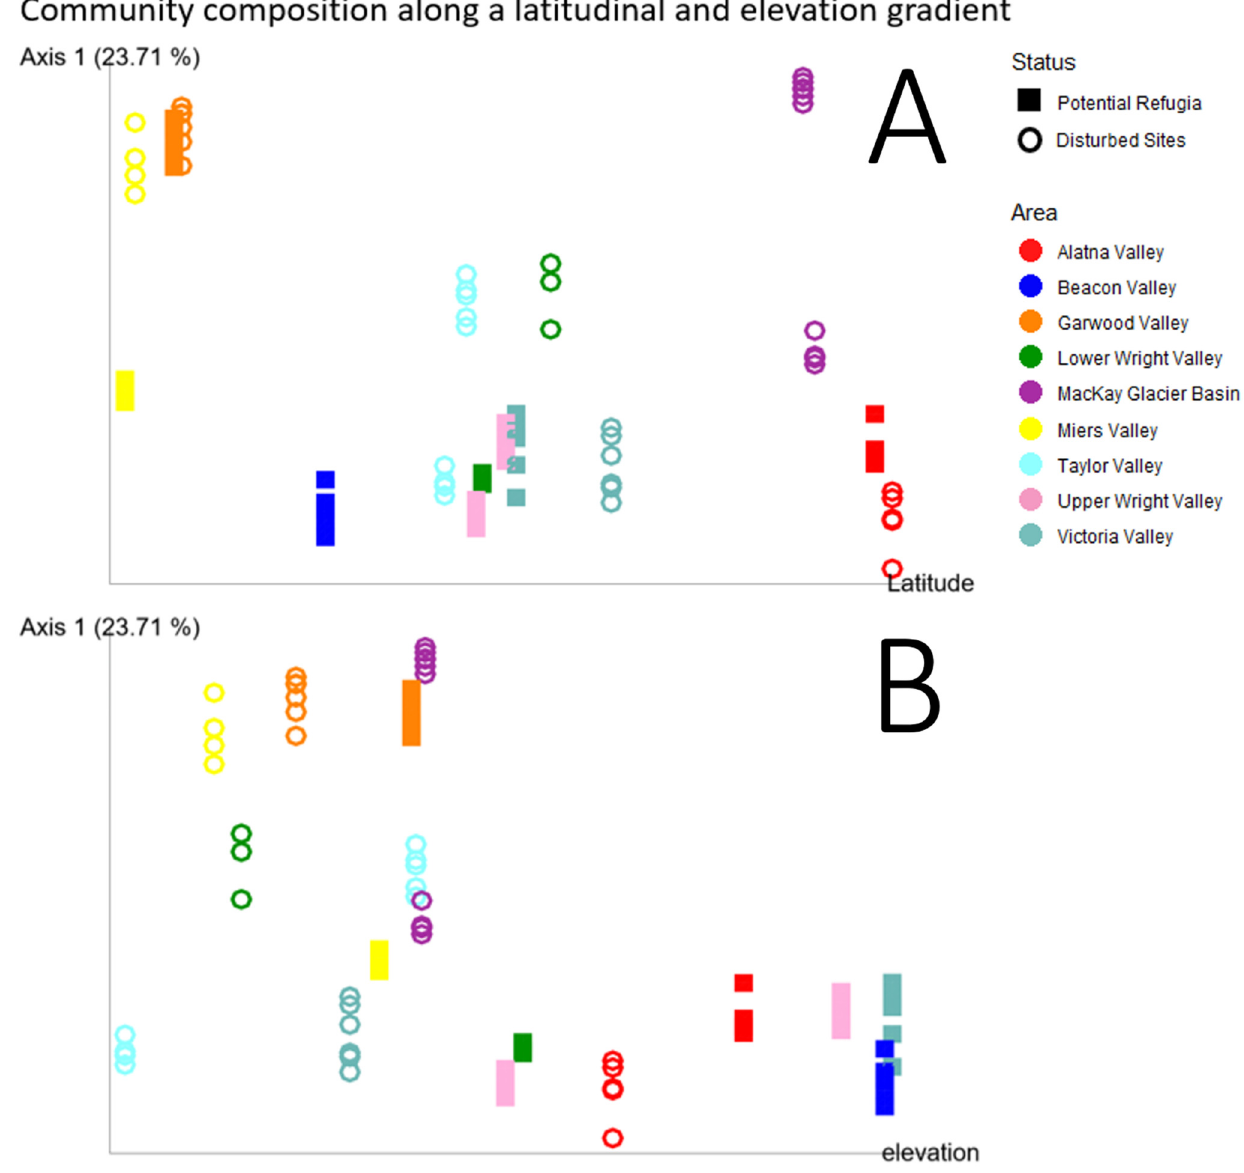
Figure 9. Community composition along a latitudinal and elevational gradient. Principal coordinate analysis of the Unweighted UniFrac diversity metric of each individual sample replicate with the principal coordinate with the highest weight on the vertical axis and latitude ( A ) or elevation ( B ) plotted on the horizontal axis. Samples taken from putative refugia sites are shown as open circles, disturbed sites are shown as squares. Colors indicate the valley basin samples originate from.